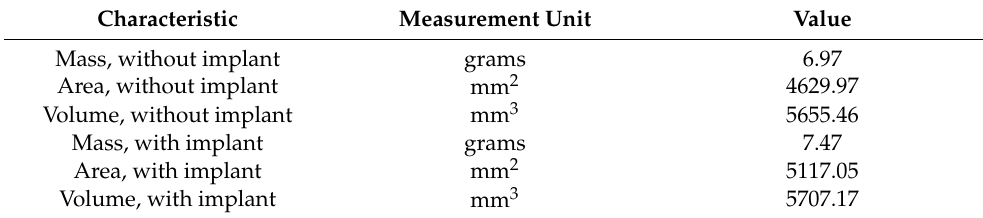
Figure 4. The 3D Model of the metal reinforcement, artificial teeth and distal implant. Table 1. The 3D models